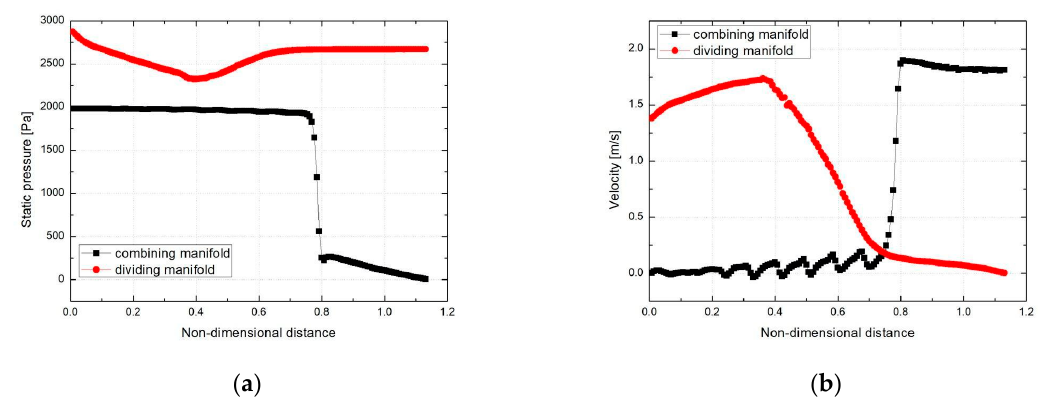
Figure 9. Pressure and velocity distributions along flow axis of Z-type manifold: ( a ) Static pressure plot; ( b ) velocity plot.